Question: Compose a caption that would accompany this figure in a paper.
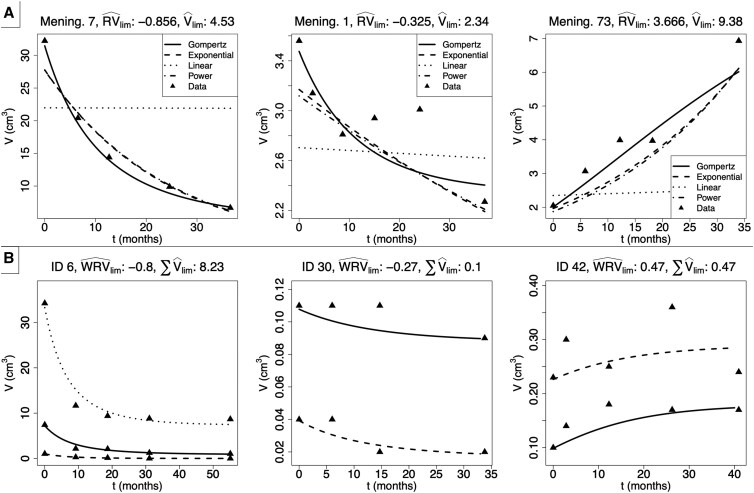
Answer: Different volumetric courses over time after CPA withdrawal. (A) Each figure represents a single meningioma, and each curve—distinguished by line type—depicts the predicted trajectory from a different model. The computation of RV ^ lim and V ^ lim can be seen on the top of each plot. Left column: strong decrease; middle column: slight decrease; right column: sustained growth. (B) Each figure represents a single patient, and each curve—distinguished by line type—corresponds to a different meningioma fitted using the Gompertz model. The computation of WRV ^ lim and ∑ V ^ lim can be seen on the top of each plot. Left column: strong decrease; middle column: slight decrease; right column: sustained growth.